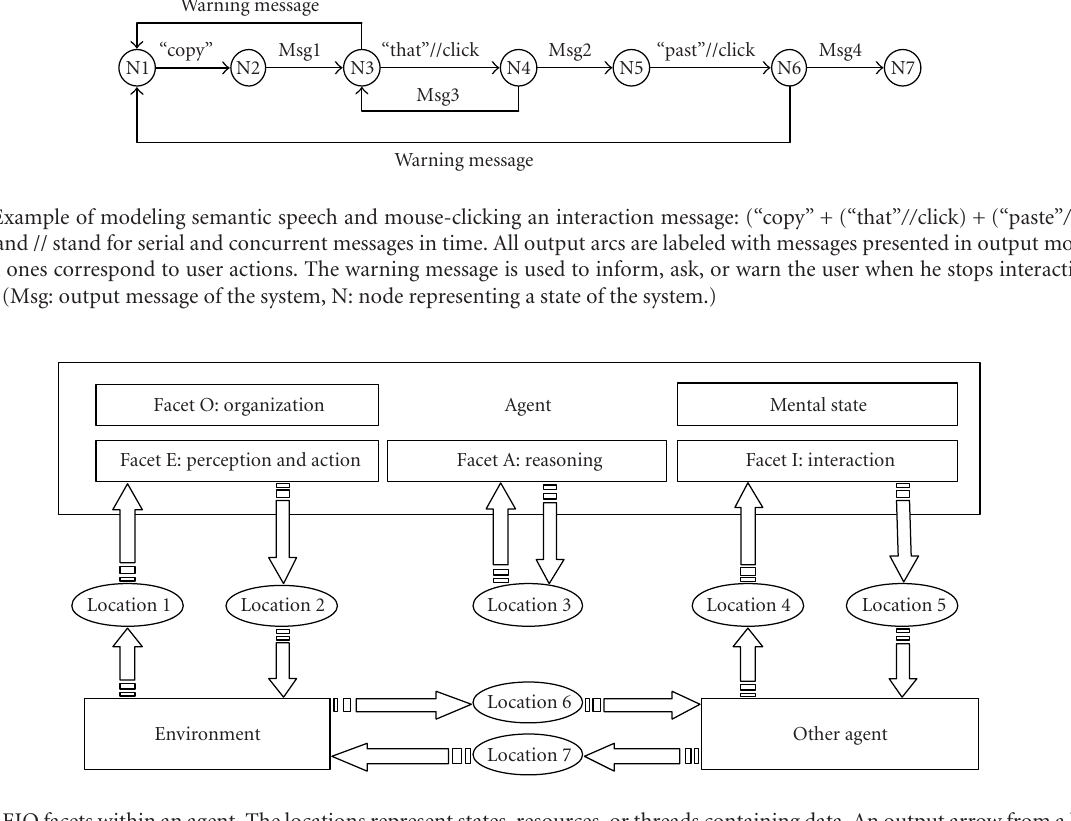
symbol FG in identical places indicates that the places are “global fusion” places [7]. These identical places are simply a unique resource (or location) shared over the net by a sim- ple graphical artifact: the representation of the place and its elements is replicated with the symbol FG. All these framed symbols—P In, P Out, HS, FG, and c —are provided and im- posed by the syntax of the visual programming toolkit of de- sign CPN